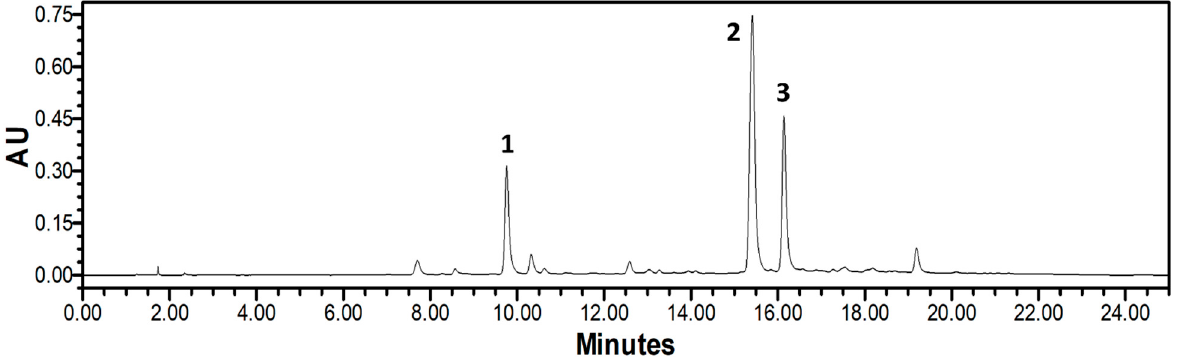
Figure 8. HPLC-PDA chromatogram of NPR extract at 325 nm. ( 1 ) Chlorogenic acid, ( 2 ) 3,5- Dica ff eoylquinic acid, and ( 3 ) 3,4-Dica ff eoylquinic